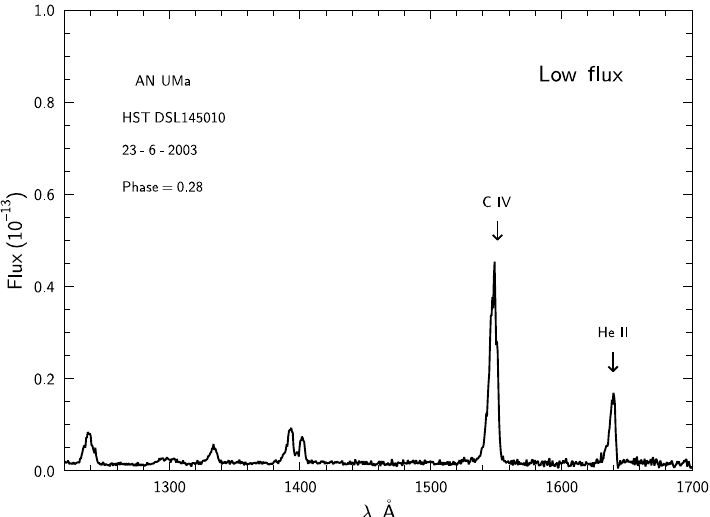
Fig. 6. IUE Spectrum of AN UMa with low (cid:13)ux at phase 0.28. The (cid:13)ux is plotted in units of erg cm (cid:0) 2 s (cid:0) 1 (cid:23)A (cid:0) 1